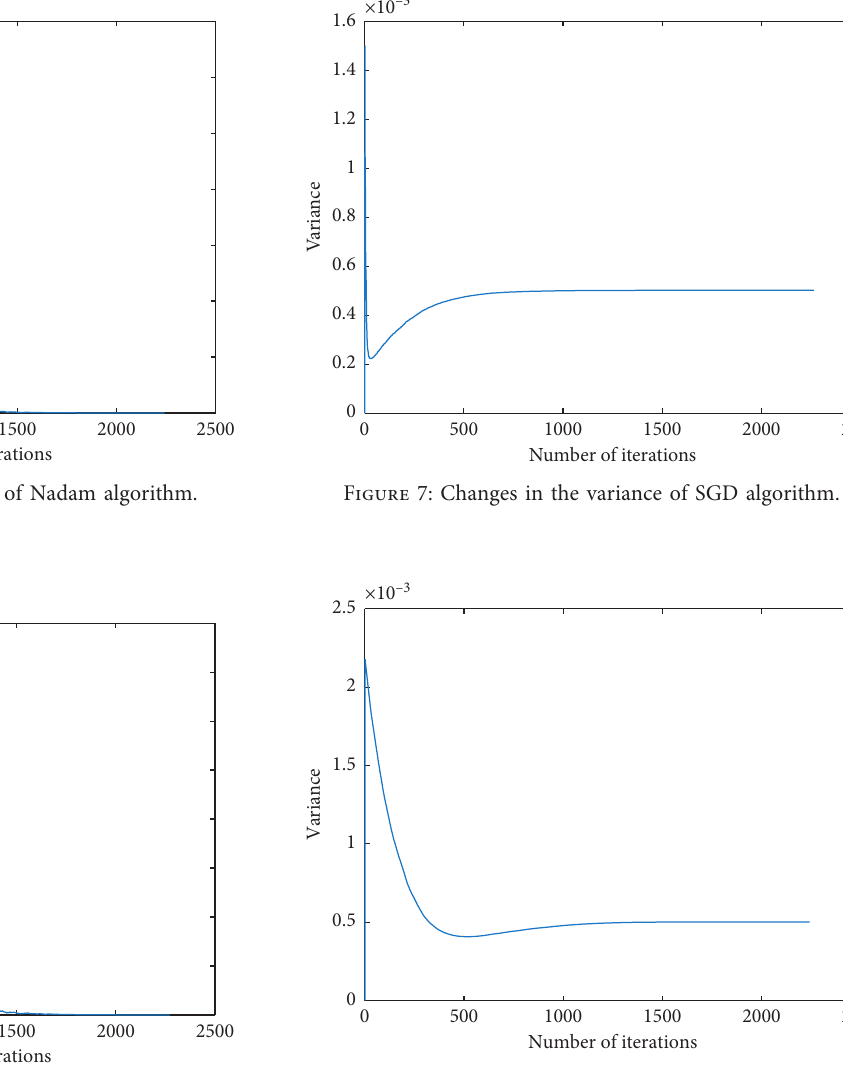
Figure 5: Convergence behavior of AMSGrad algorithm.